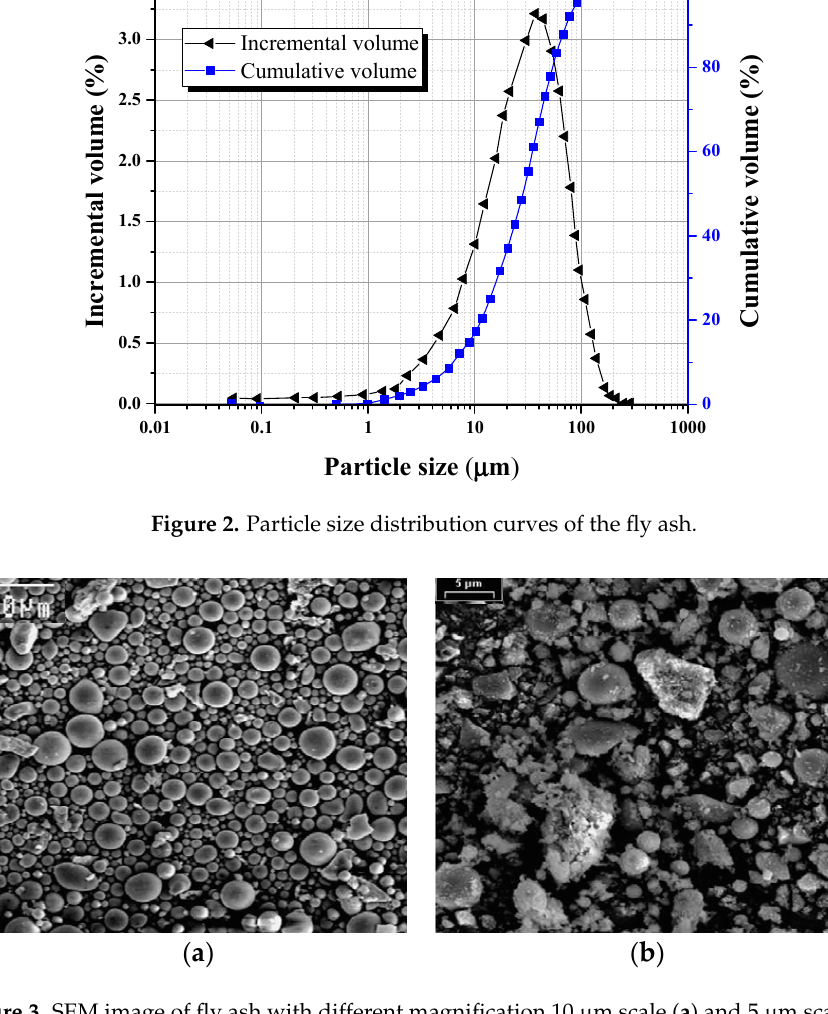
Figure 3. SEM image of fly ash with different magnification 10 μ m scale ( a ) and 5 μ m scale ( b ).